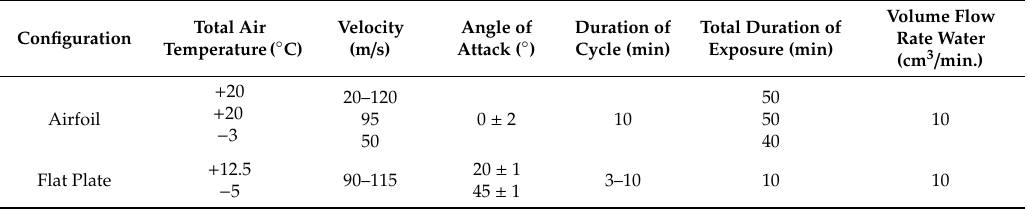
Table 1. List of conditions used for icing wind tunnel durability